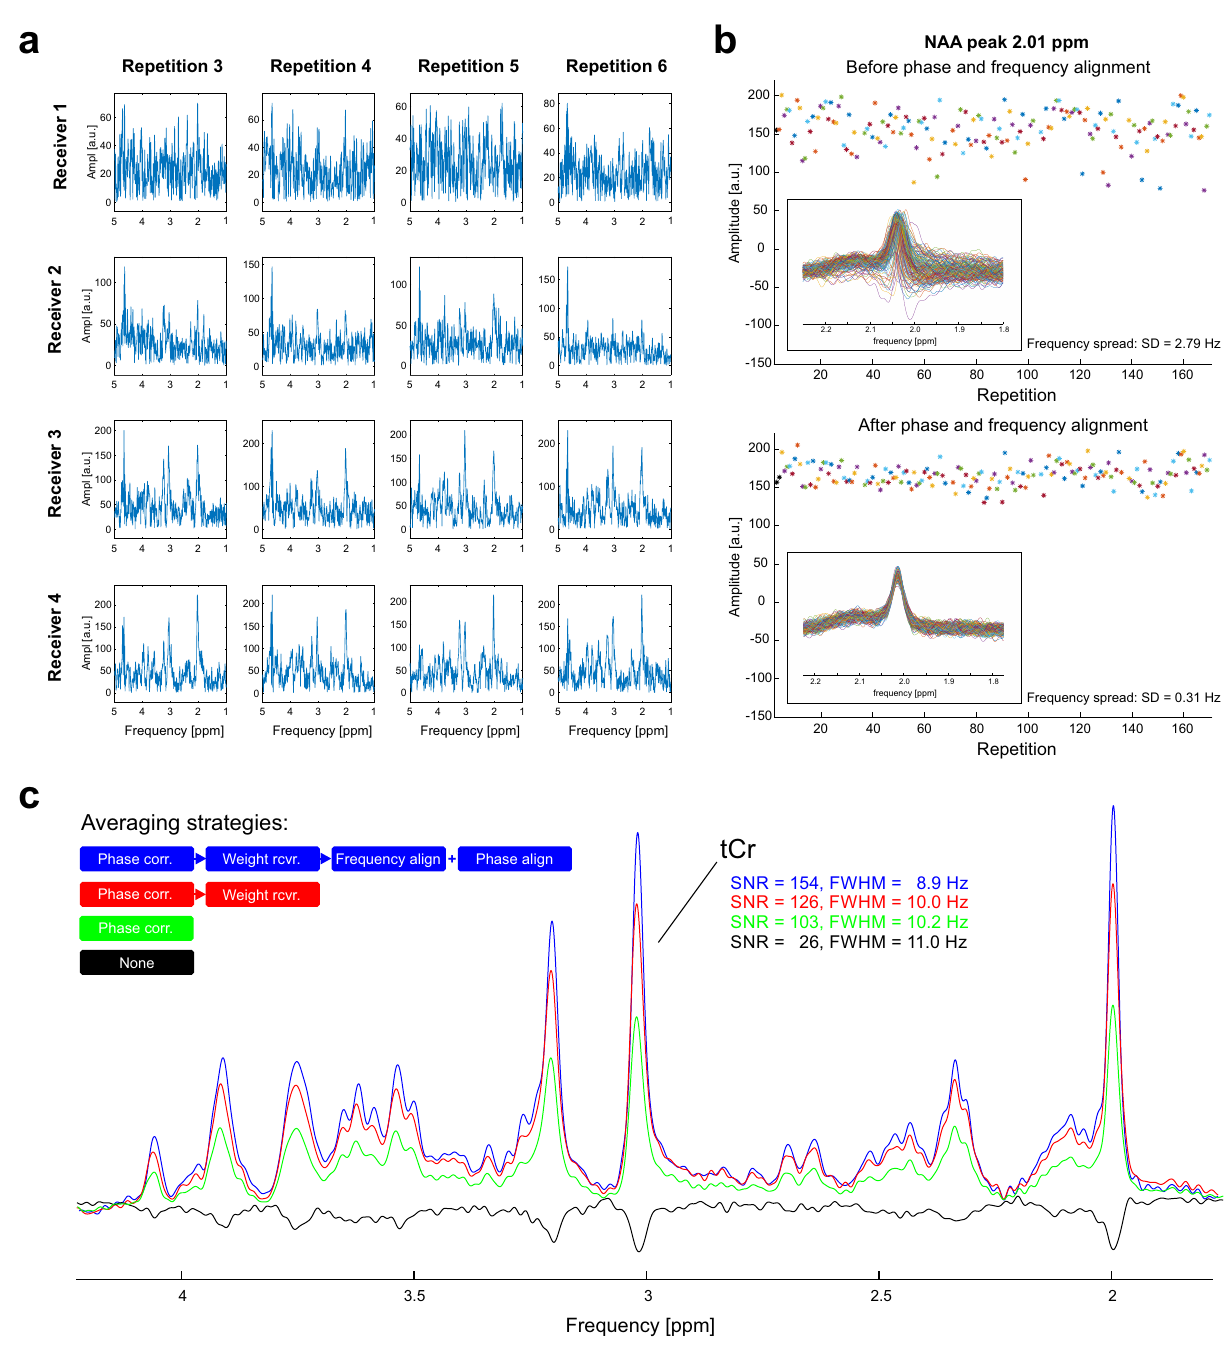
Figure 3. Data inspection and preprocessing in INSPECTOR. ( a ) Visualization of all individual repetitions from all coil channels in magnitude mode on the Data page. Note the increased signal-to-noise ratio (SNR) in receiver #4 due to close proximity to the MRS voxel position compared to receiver #1, which was furthest away. ( b ) The quality assessment (QA) tool allows signal visualization before and after alignment of individual repetitions with the Align tool. ( c ) Example of four different averaging strategies and their impact on SNR and full width at half maximum (FWHM) of the tCr signal at 3.03 ppm measured in the brain at 7 T. Data averaged without any processing resulted in the lowest spectral SNR and the highest FWHM, and the spectrum was out of phase (black). Phase correction for channel combination improved the SNR and FWHM (green). Additional sensitivity-weighting of individual coil channels further improved SNR (red). The best spectral quality was achieved by also correcting for relative phase and frequency variations between scan repetitions